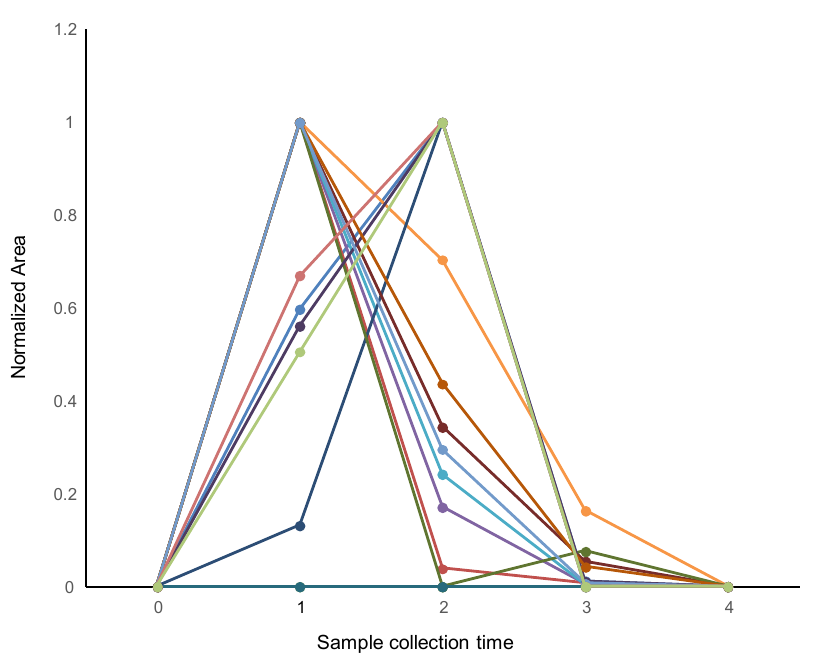
Figure 2. Time evolution profiles of the amount of the new compounds detected after the rt-PA administration (determined from the peak area obtained with the UV detector and normalized to the highest peak area measured for each patient). Quality control measurements were daily performed to assure the accuracy and reproducibility for UV and FL measurements. Each colored line corresponds to the results obtained for the same treated patient.